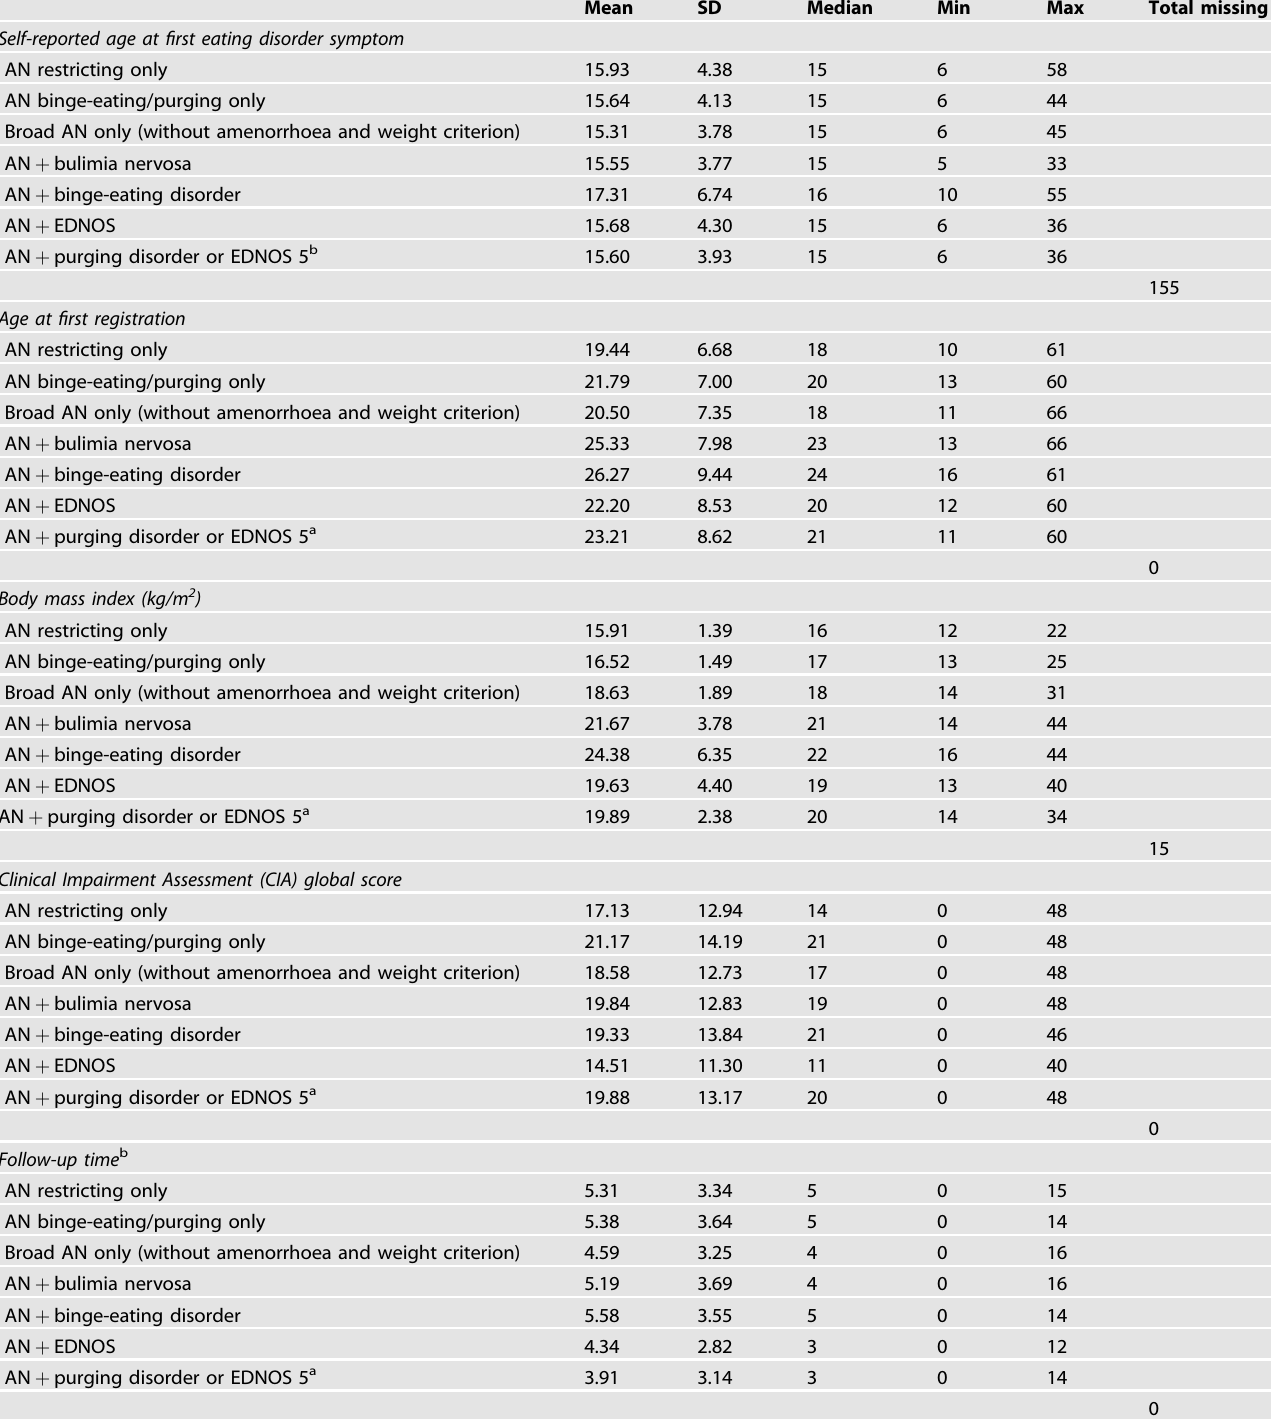
Table 2. Descriptive statistics of quantitative demographic and clinical characteristics of the target sample ( n = 2843) of specialised eating disorder care in Sweden. Mean SD Median Min Max Total